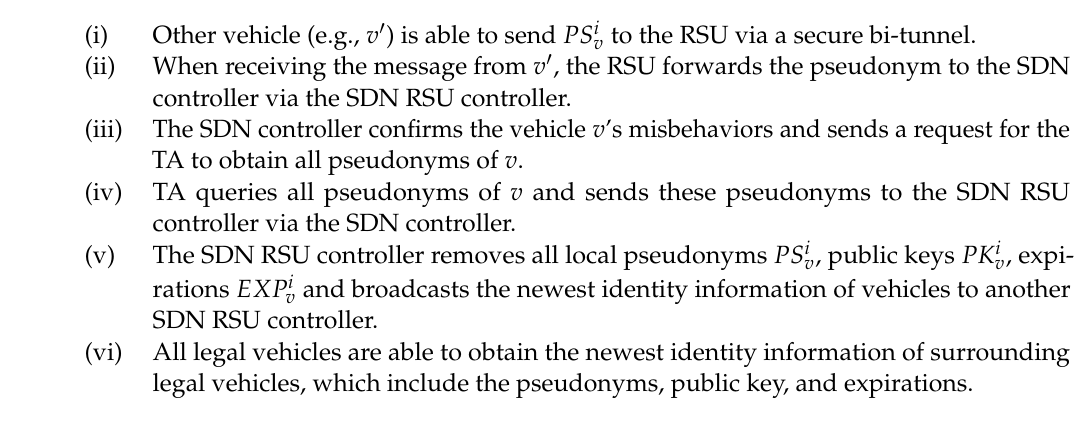
Figure 7. Vehicle revocation